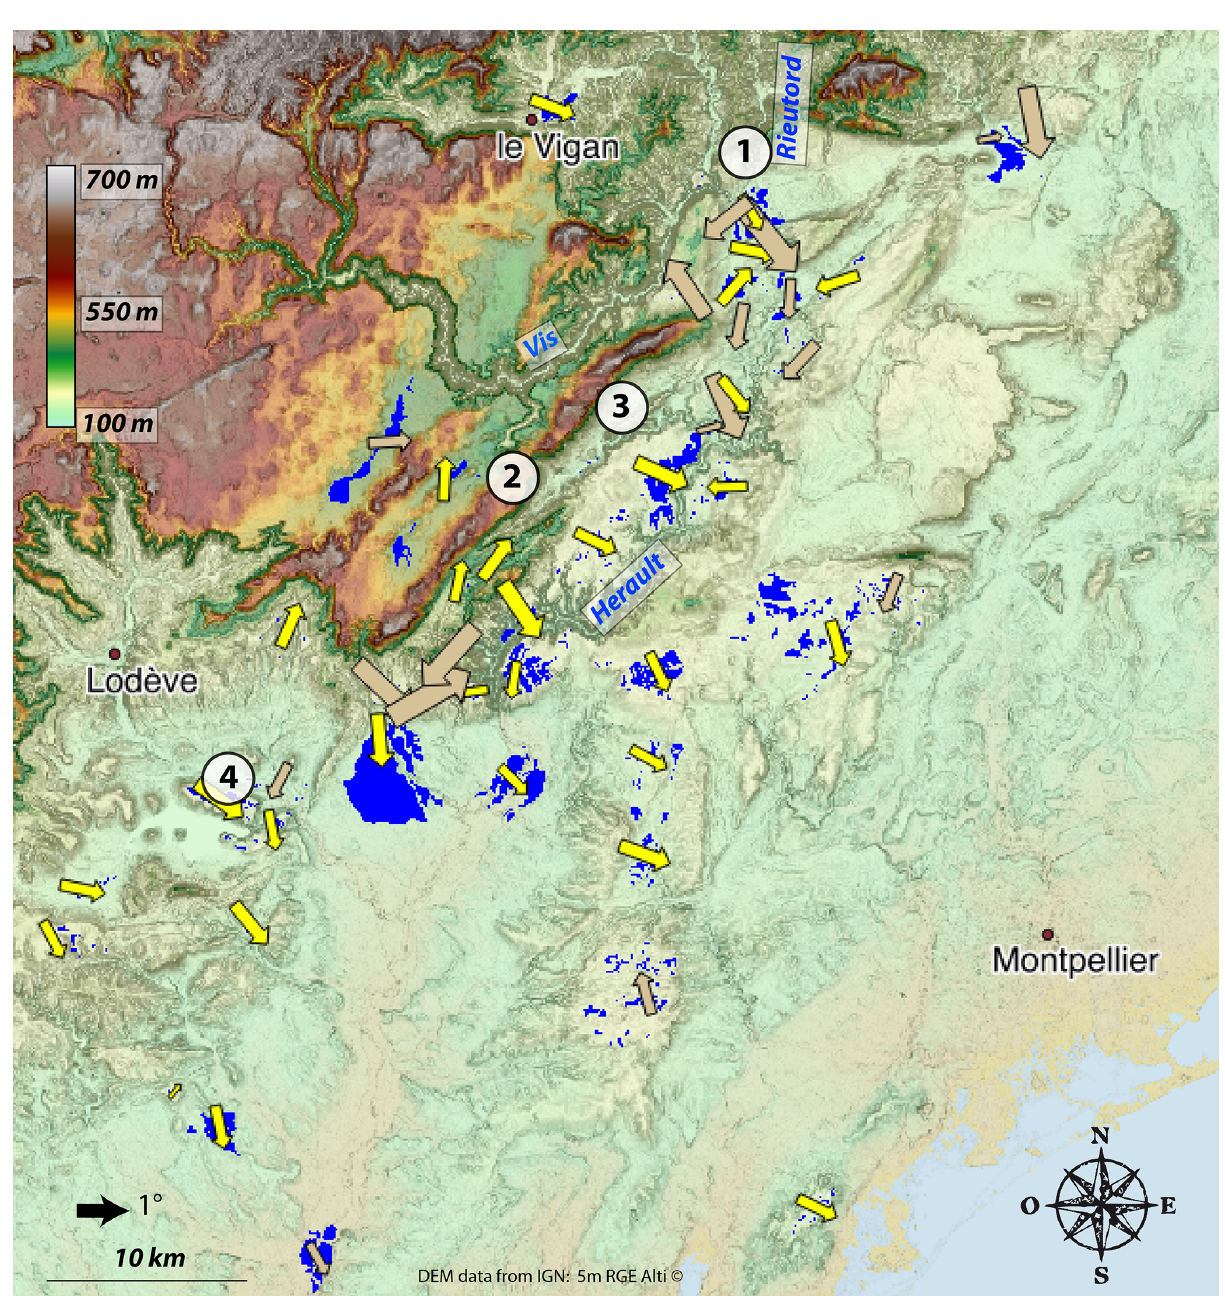
Figure 9. Tilting map of geomorphological benchmark (blue areas). Base map is 30m resolution DEM with slope shadow. Arrows are oriented according to the marker downward dip. The arrow size is set according to the corrected tilting angle (the bigger the arrow, the more the tilting). Yellow and brown arrows are for robust and less robust surfaces, respectively. Several arrows are hidden because of their small size and too high of proximity to bigger ones. Enumerated site (1) is the Rieutord canyon, (2) is the Leicasse cave system, (3) is the Garrel cave system, and (4) is the Lodève basin with dated basaltic flows. See Fig. 1 for geographical